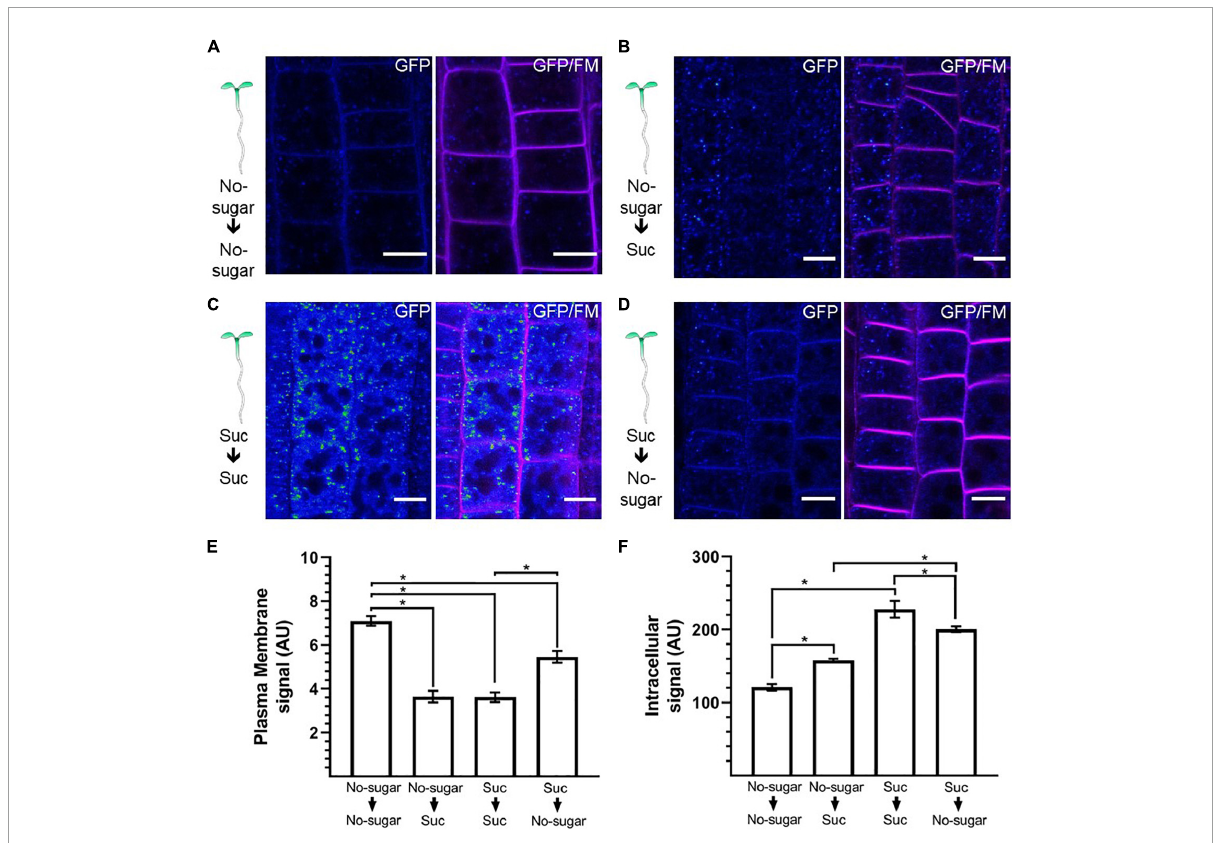
FIGURE6 Endocytosis is dynamically and reversibly modulated by sucrose. Arabidopsis transgenic CLC2-GFP plants were grown for 7 days on sugar-free (0 mM; No sugar) (A,B) or sucrose-supplemented (60 mM; Suc) (C,D) solid medium. Seedlings were transferred to sugar-free (A–D) or sucrose-containing medium (B,C) for 24 h. The cellular distribution of CLC2-GFP was evaluated in root epidermal cells. The plasma membrane was labeled with FM4-64. Representative confocal images of n = 15 seedlings under each condition are shown. The GFP signal is shown as Rainbow RGB LUT (Fiji). Bar, 10 µ m. (E,F) The fluorescent signal at the plasma membrane (E) and the intracellular compartments (F) was quantified in CLC2-GFP seedlings. AU: arbitrary unit. Error bars represent standard error for three independent biological replicates ( n = 15 seedlings). Two-tailed Student’s t -test; * p <